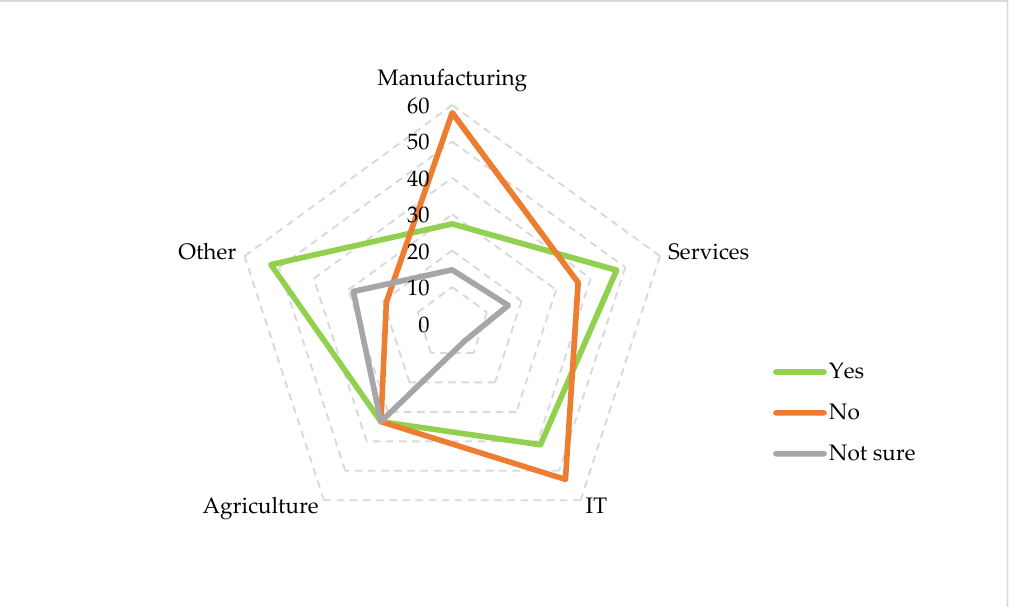
Figure 3. The data visualisation about awareness of the SDGs, according to a sector of the employer (own elaboration, 2021).